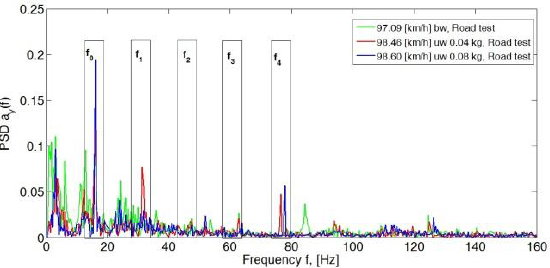
Figure 9. Power spectral density graph of the body acceleration signal for a speed of 100 km/h.